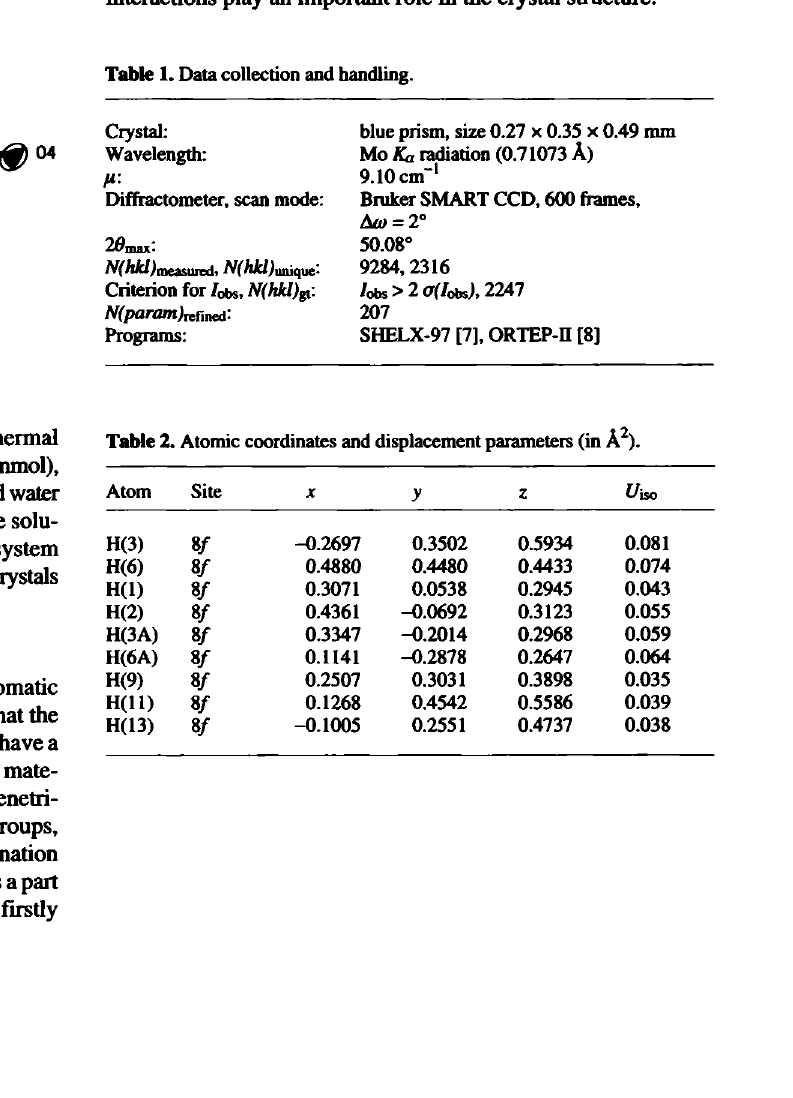
Table 1. Data collection and handling.